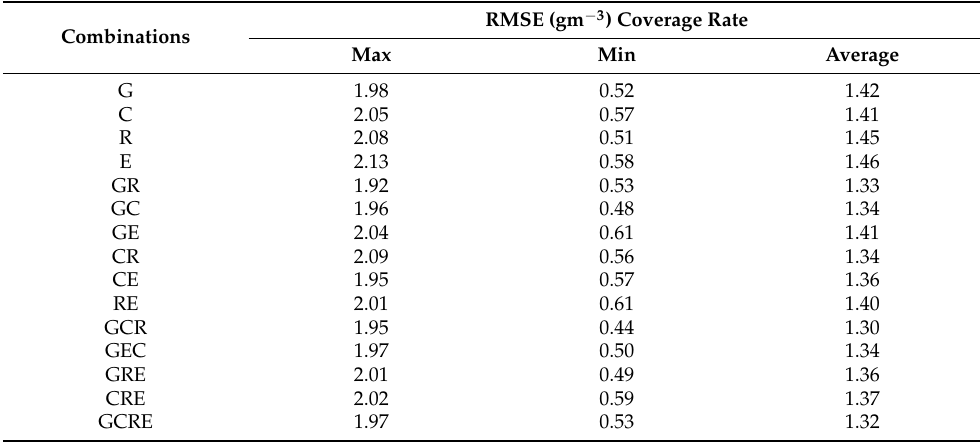
Table 2. Statistical results of the water vapor density composition between radiosonde and tomo- graphic results of different combinations during the experimental